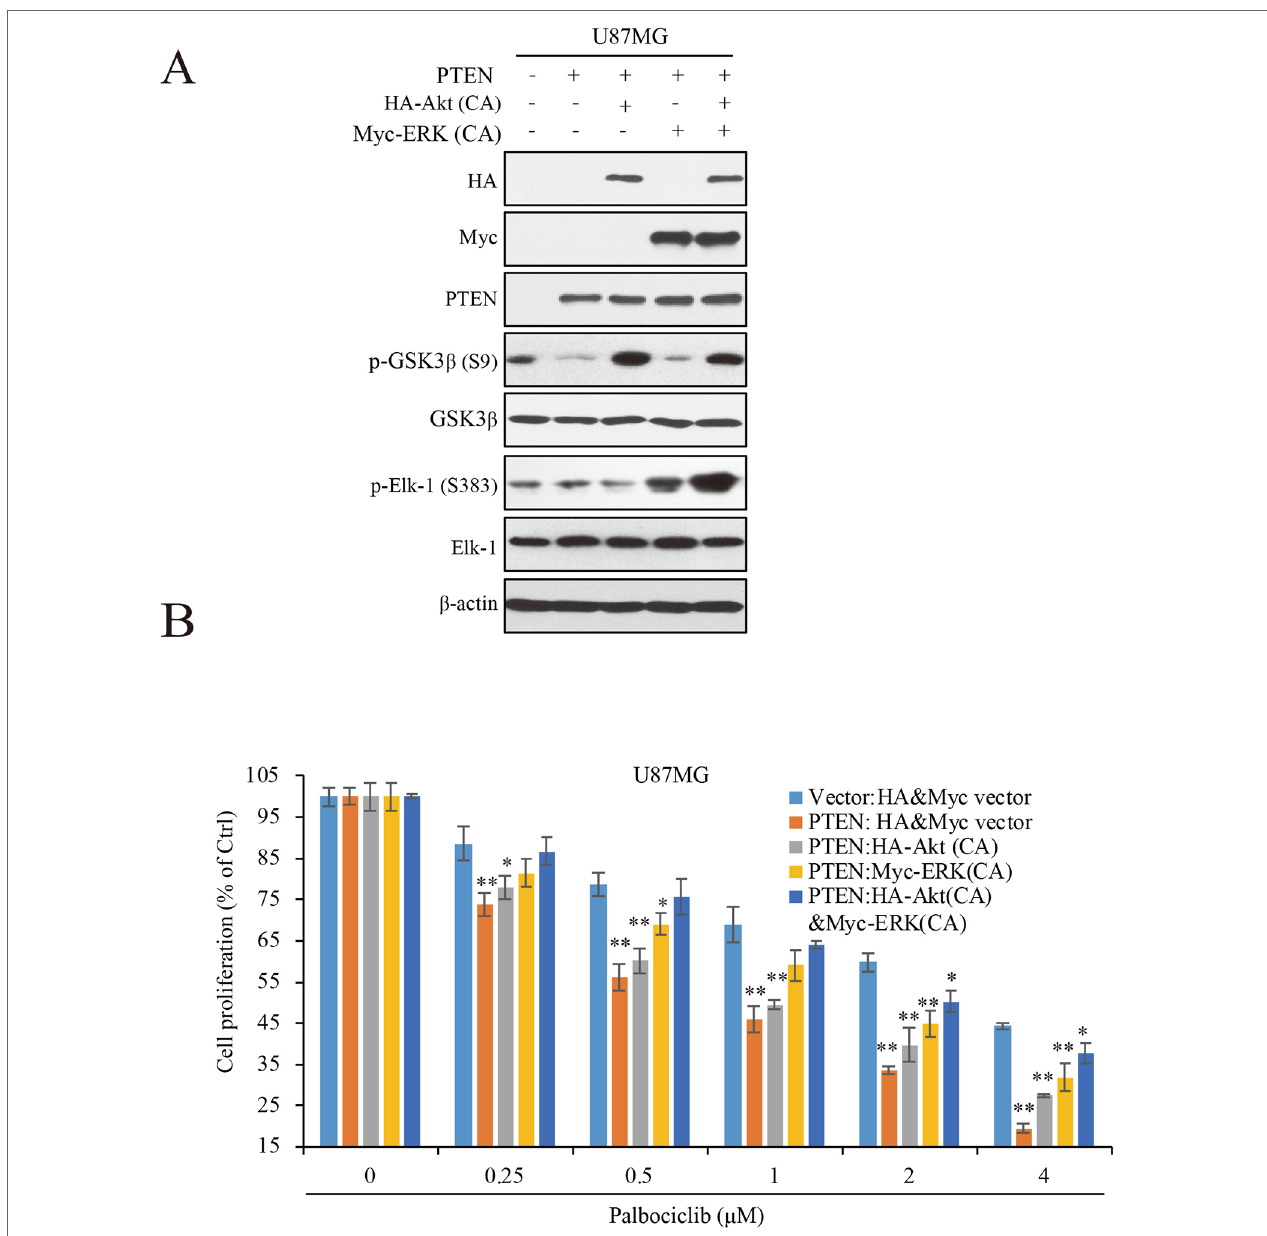
FIGURE 5 | ERK and Akt activation alleviates palbociclib-induced suppression of GBM cells. (a) Validation of the cell systems with active ERK or/and Akt activation. U87MG isogenic cells were transfected with ERK-CA or/and Akt-CA plasmids. Cell lysates were collected and examined by western blot assay with indicated antibodies. (B) Effects of palbociclib on cell proliferation in the cell systems constructed in (a) Following palbociclib treatment, cell proliferation was assessed by MTT assay as described in Materials and Methods . Data are expressed as mean ± SD (* P 0.05, ** P 0.01, vs. control cells in each dose group, t -test, n = 3).